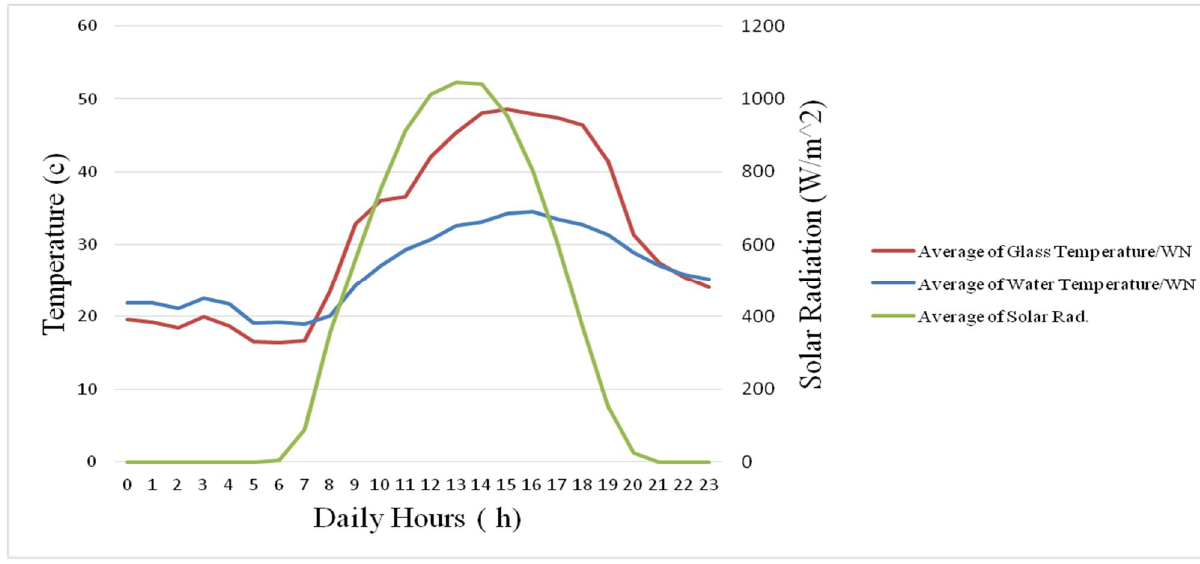
Figure 3. Hourly solar radiation and glass and water temperatures for 0.4% concentration of Al 2 O 3 .